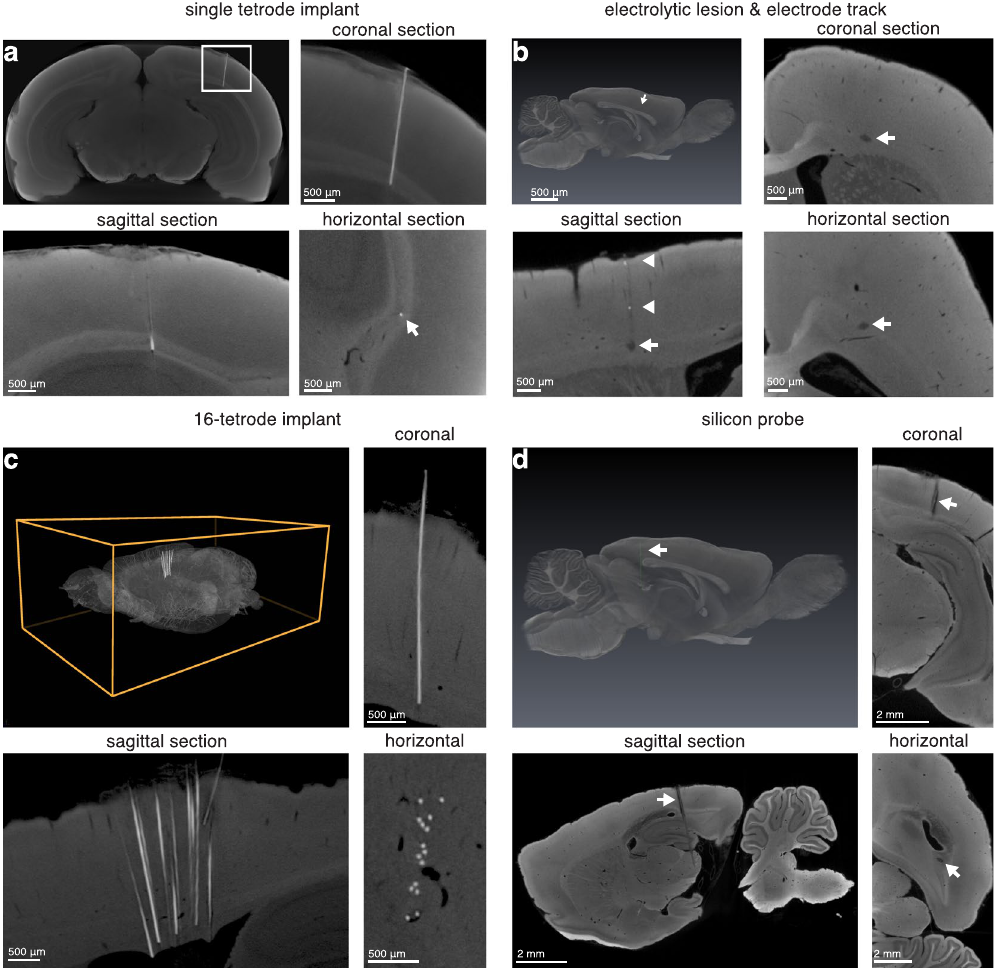
Figure 5. Electrode localization through micro-CT imaging. ( a ) Single tetrode left in situ (14.0 μ m voxels). Top left panel : Max-intensity projection of virtual coronal sections showing location of nichrome tetrode traveling through visual cortex into the corpus callosum of a rat. Top right : Close-up of image shown in top left panel of (a) (white rectangle). Bottom left : sagittal and Bottom right : horizontal views of the implanted electrode (white arrow indicates location of the tetrode). ( b ) Electrolytic lesion and electrode track in anterior region of a rat brain (13.9 μ m voxels). Top left : 3D rendering of brain with electrolytic lesion segmented out (white arrow indicating purple lesion). Top right : coronal, Bottom left : sagittal and Bottom right : horizontal sections indicating electrolytic lesion (white arrows) produced with a 75 μ m diameter tungsten electrode. In addition, some metal deposited by the electrode upon retraction is visible along the track in the sagittal view (white arrowheads). ( c ) 16-tetrode implant left in situ in anterior cortex of a rat brain. Top left : 3D rendering of whole brain with 16-tetrode array left implanted. Top right : coronal, Bottom left : sagittal and Bottom right : horizontal sections indicating 16-tetrode implant (8.9 μ m voxels). ( d ) Silicon probe (10 mm shank, 32 sites) left in situ traveling through posterior cortex, hippocampus and subcortical structures (13.9 μ m voxels). Top left : 3D rendering of whole brain with segmented silicon probe (white arrow indicating green probe). Top right : Coronal, Bottom left : sagittal and Bottom right : horizontal views of silicon probe in the brain. Additionally, the reference site on the silicon probe is visible in the coronal and sagittal sections (tip of white